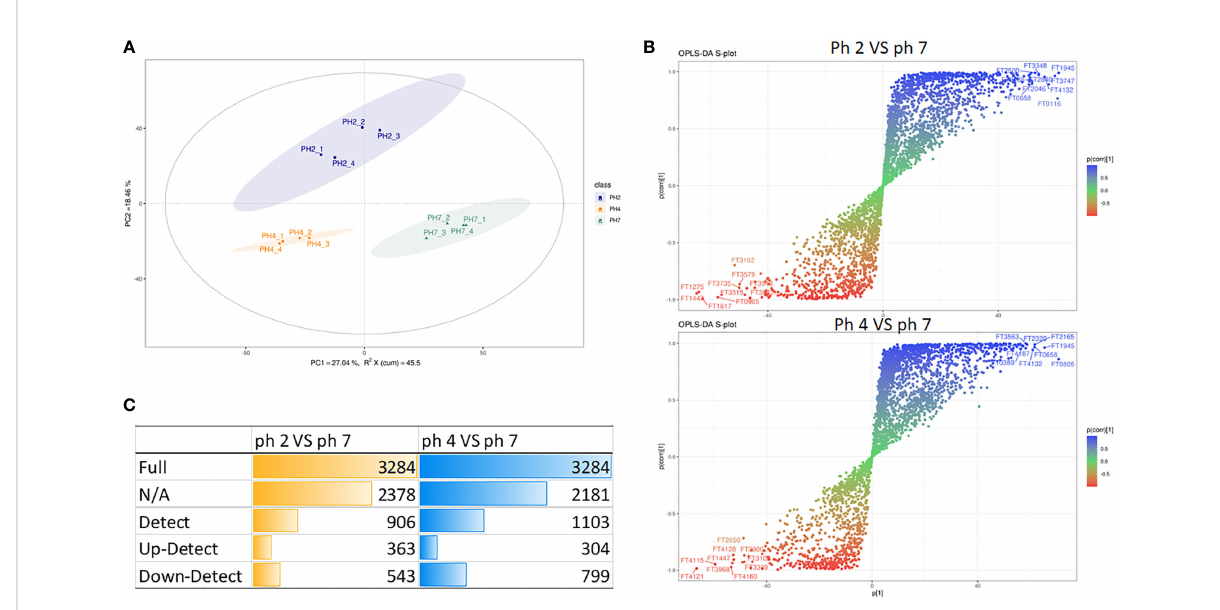
FIGURE 4 LC-MS metabolite analysis of the pH 2 vs. pH 7 and pH 4 vs. pH 7 groups: (A) PCA scree plots display a high resolution separation among the pH 2, 4, and 7 groups; (B) OPLS-DA analysis indicate that the prominent bioactive metabolites in the pH 2 vs. pH 7 and pH 4 vs. pH 7 groups are signi fi cantly changed; (C) the different sample analyses of the pH 2 vs. pH 7 and pH 4 vs. pH 7